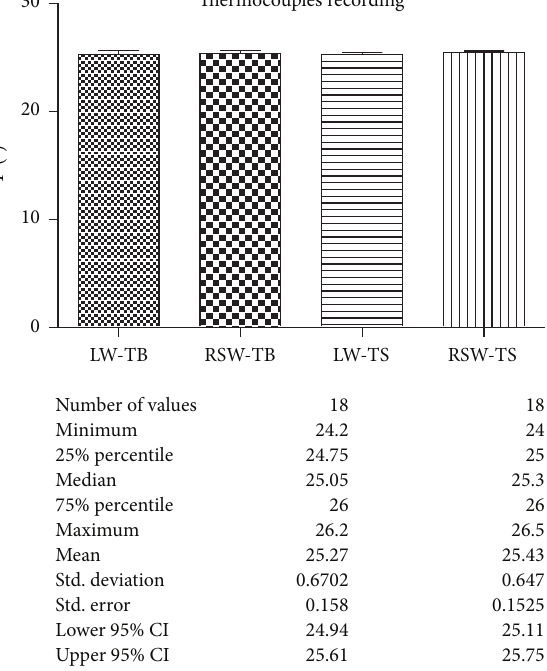
Figure 9: Comparison of the temperature in the bone (TB) and in the implants (TS) recorded by K-thermocouples during laser welding (LW) and spot resistance welding (RSW). Description of the statistical analysis used is shown